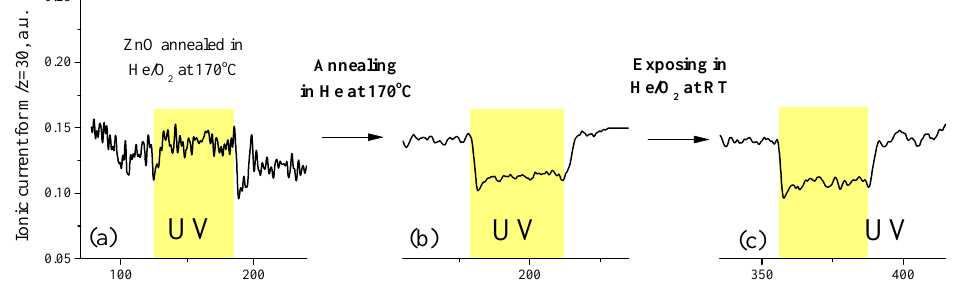
Figure 13. NO 2 photoadsorption experiments on ZnO samples with different treatment history: ( a ) as-prepared ZnO was post-annealed in (He + 20% O 2 ) atmosphere at 170 ◦ C for 12 h (arrows show “turn-on”- and “turn-off”-induced photoadsorption peaks); ( b ) ZnO sample after annealing of the previous sample in He atmosphere at 170 ◦ C for 12 h; ( c ) ZnO sample after exposing of the previous sample in (He + 20% O 2 ) atmosphere at RT for 12